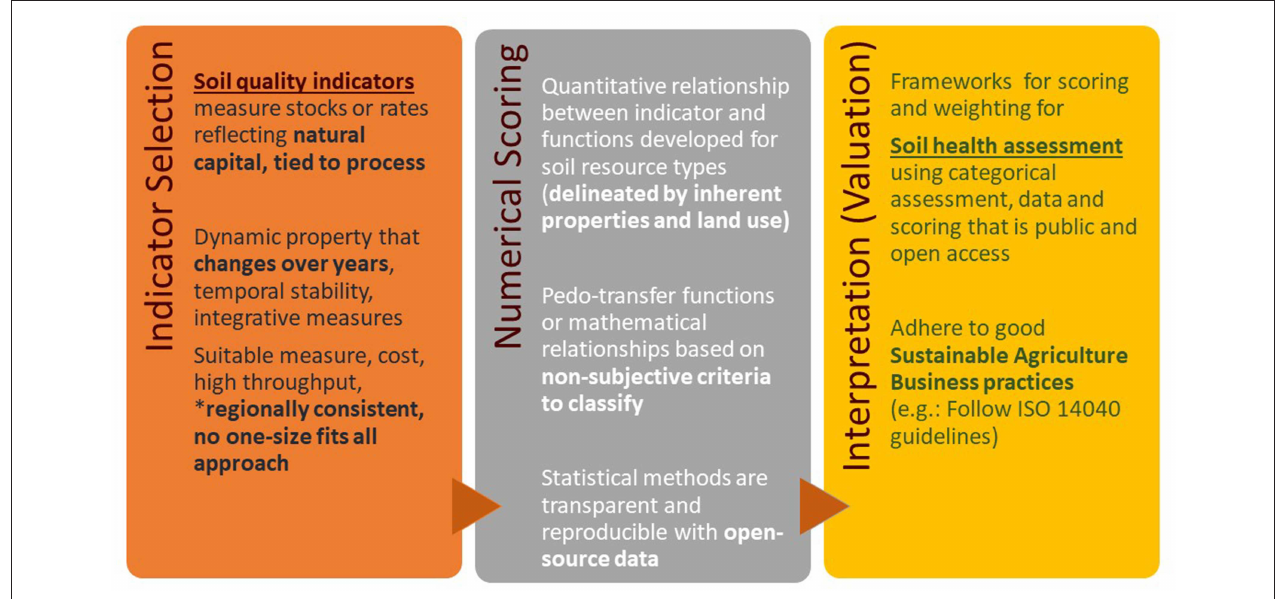
FIGURE 1 | Steps in the use of soil quality indicators within soil health